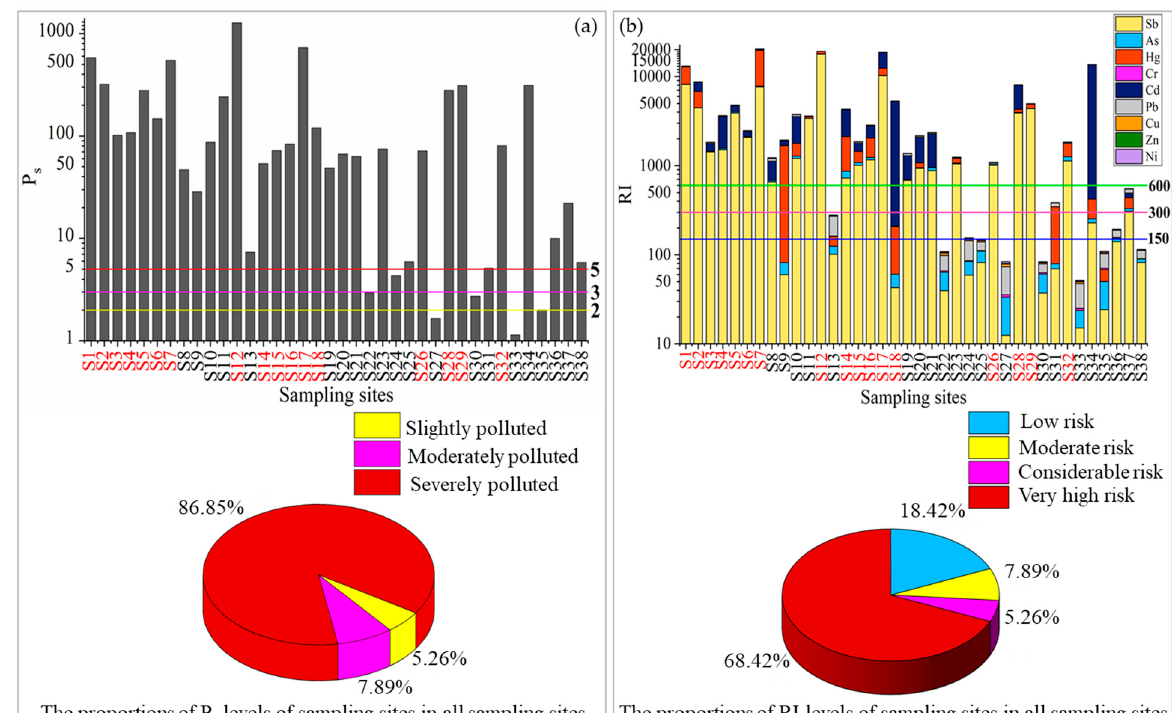
Figure 2. Values and classification proportion of the Nemerow’s comprehensive index ( Ps ) ( a ) and the potential ecological risk index ( RI ) ( b ) for heavy metals in soils of the study area. The sites which are located in the mining area are labeled by coloring the IDs in red.